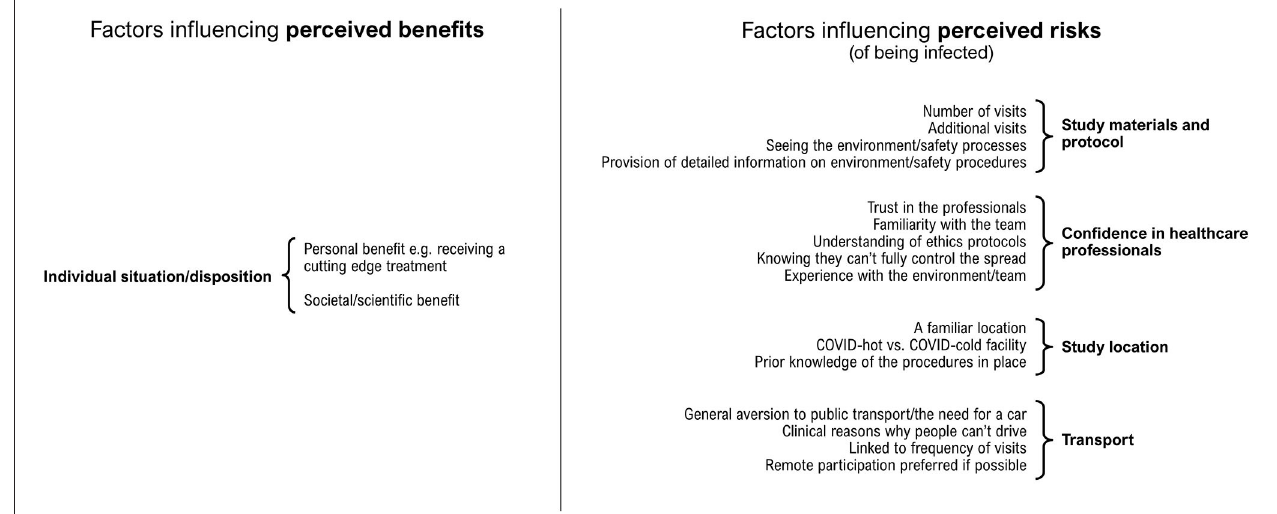
FIGURE 1 | Factors that were associated with participants’ perceptions of costs, or perceptions of benefits, of participating in a cancer research study during 2020, the first year of the COVID-19